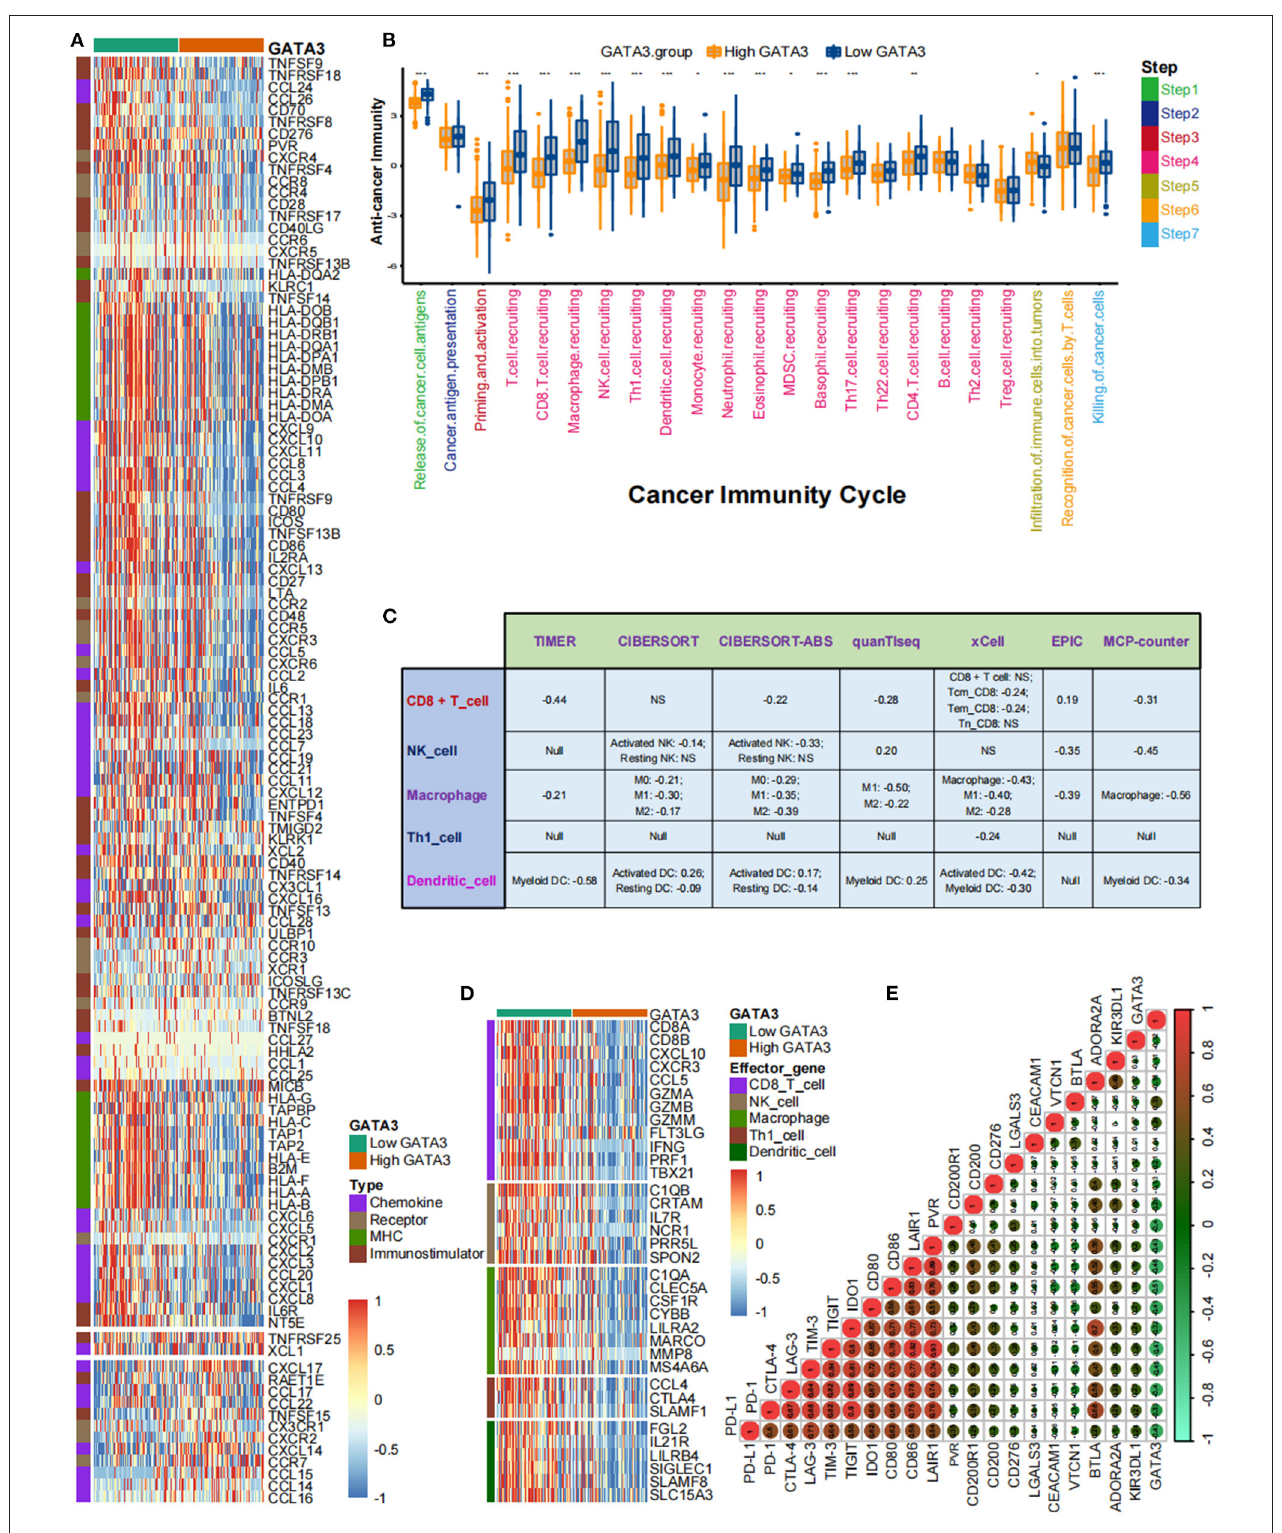
FIGURE 3 | GATA3 correlated with the tumor immune microenvironment in BLCA. (A) Differential expression of GATA3 between high- and low-GATA3 tissues in BLCA. (B) Differential expression of GATA3 among various steps of the anti-tumor immune cycle. (C) Correlation between GATA3 and the infiltration levels of five TIICs with various algorithms. (D) Differential expression of effector genes of five mentioned TIICs between high- and low-GATA3 tissues in BLCA. (E) Correlation between GATA3 and 20 inhibitory immune checkpoints.